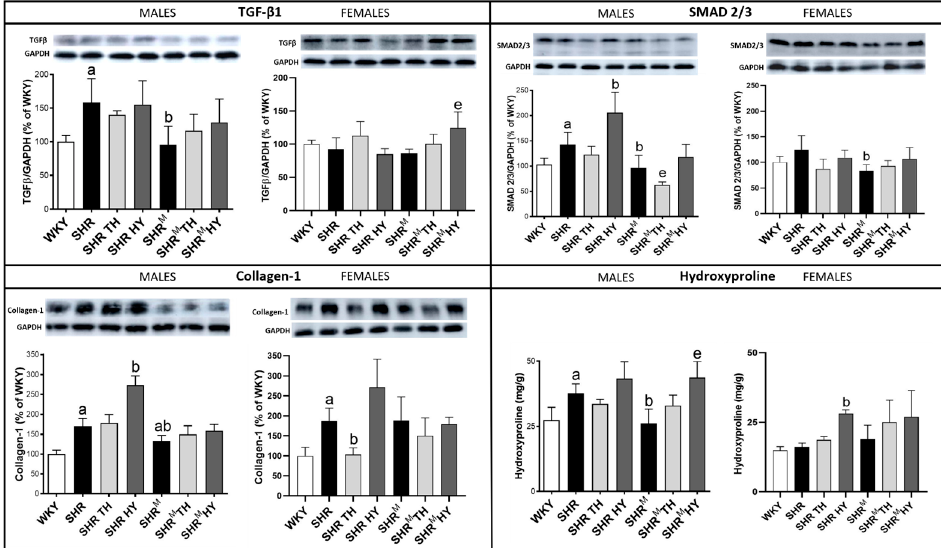
Figure 10. Myocardial protein levels of profibrotic markers TGF- β 1, SMAD2/3 and Collagen-1 determined by Western blotting, as well as the levels of hydroxyproline. Note the reduced levels of these proteins in hairless SHR M compared to wild type SHR, apparently in males. WKY—Wistar Kyoto normotensive control rats, SHR—wild type spontaneously hypertensive rats, TH—hyperthyroid rats, HY—hypothyroid rats and SHR M —hairless spontaneously hypertensive rats, n = 5 per group. Data are presented as means ± SD, a p < 0.05 vs. WKY, b p < 0.05 vs. SHR and e p < 0.05 vs. SHR M . One-way ANOVA and Bonferroni’s multiple comparison tests were used as the statistical method.